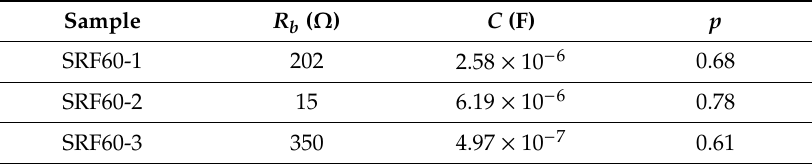
Figure 8. Nyquist plots of ( a ) SRF60-1, ( b ) SRF60-2, ( c ) SRF60-3, and ( d ) the corresponding equivalent circuit. Table 5. Equivalent circuit parameters of high-conductivity